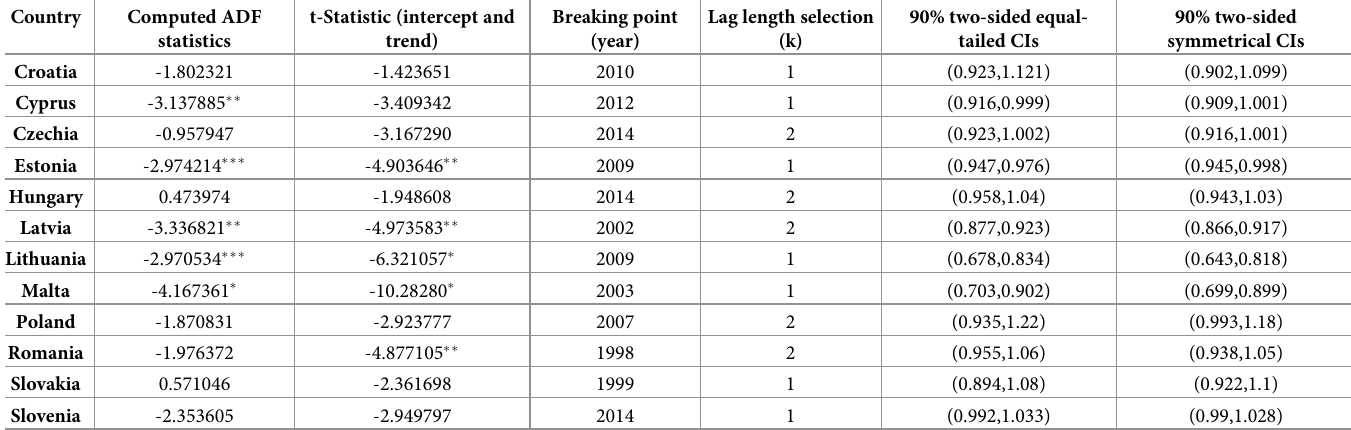
Table 6. Results of univariate ADF and structural break-accounting Zivot-Andrews tests and subsampling confidence intervals for EU-13 countries